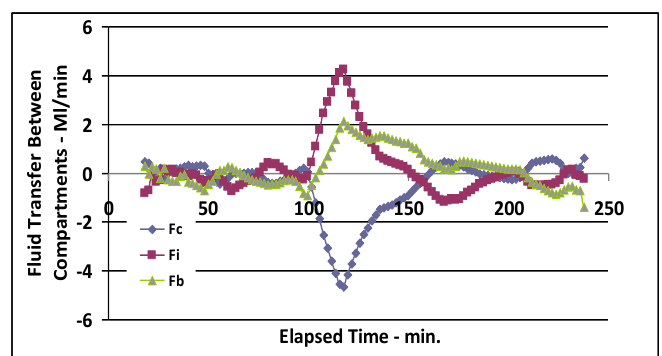
Figure 4. Fluid transfer in and out of the cells (Fc), interstitial space (Fi), and intravascular compartment (Fb) vs. elapsed time.